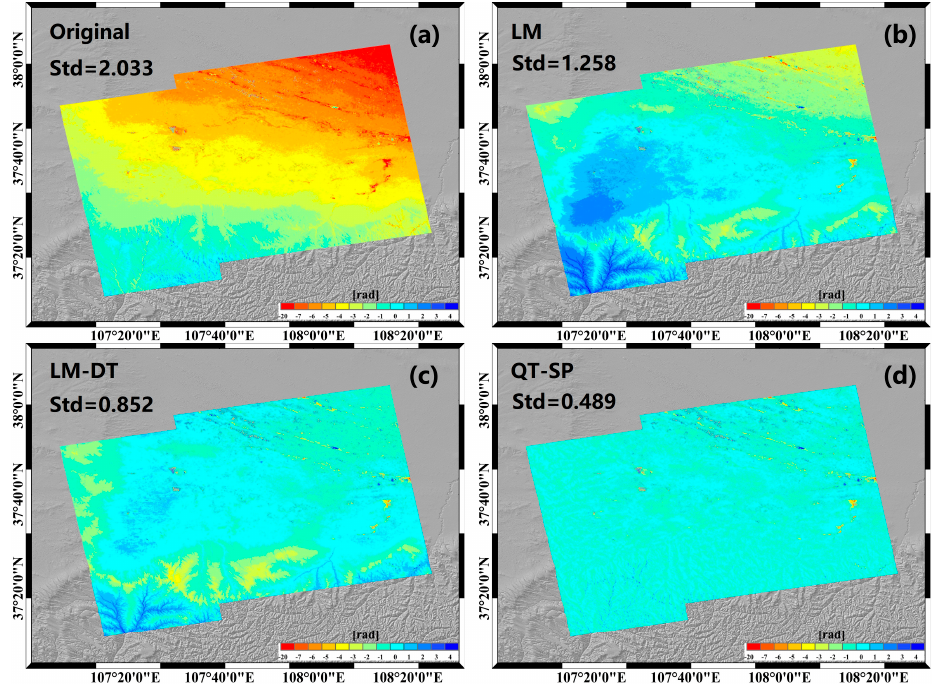
Figure 3. The unwrapped phase of Sentinel − 1A images acquired on 11 January 2018 and 23 January 2018 in the transition zone from southern mountain to northern desert. ( a ) Original unwrapped phase; ( b ) atmospheric phase correction by linear model (LM), ( c ) atmospheric phase correction by linear detrend method (LM − DT) and ( d ) atmospheric phase correction by quadtree segmentation process (QT − SP).